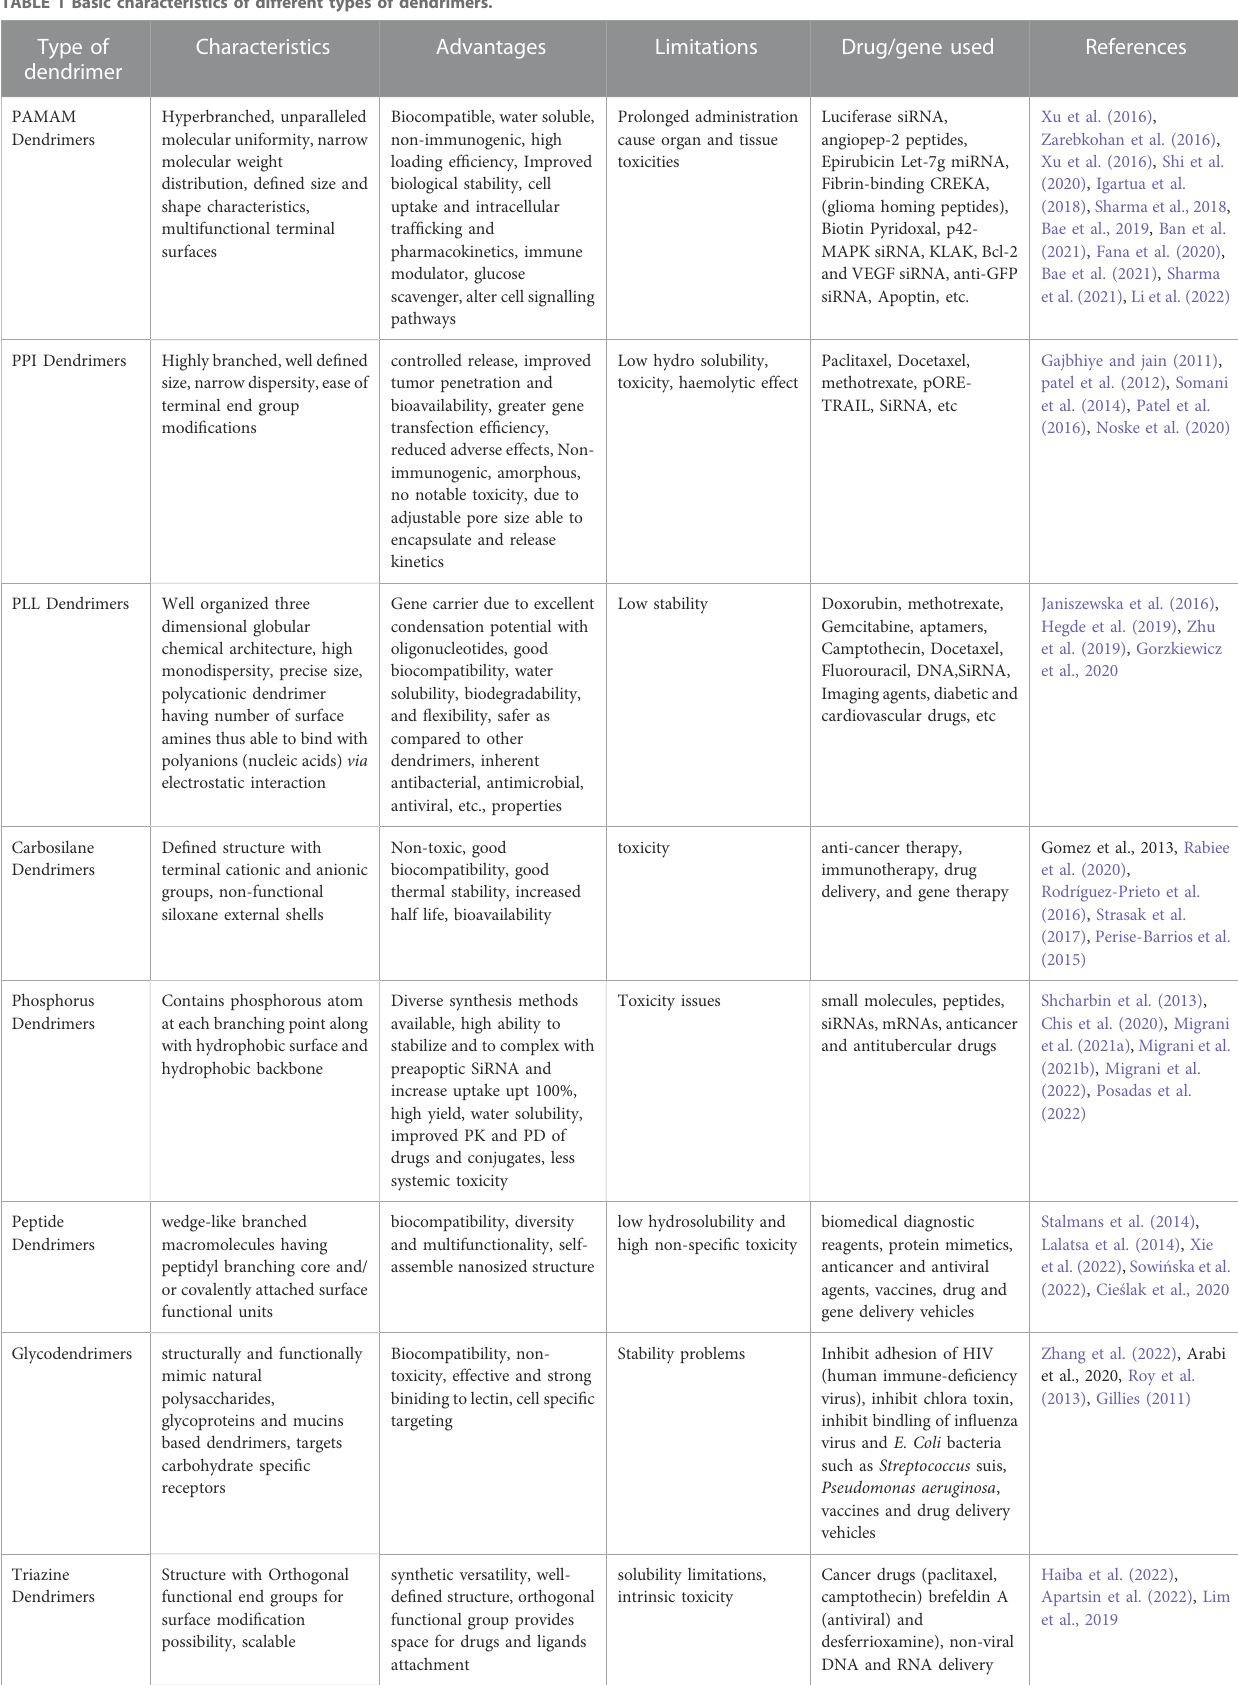
TABLE 1 Basic characteristics of different types of